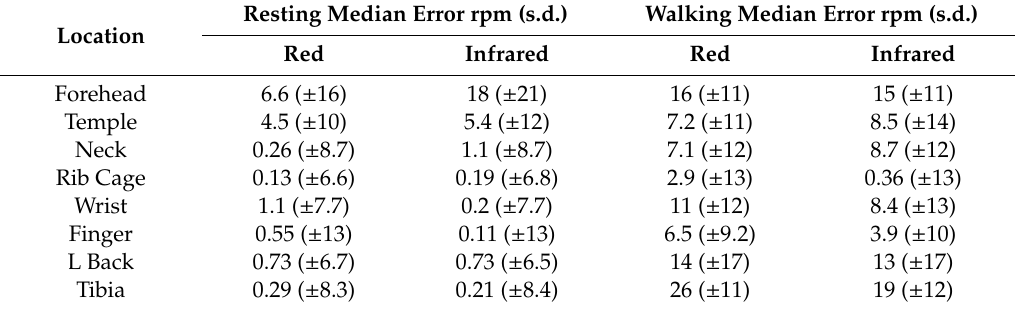
Table 5. Median error for respiration calculation at eight anatomical location using the red Rib Cage and infrared channels at rest and walking. Median error is presented as the respirations per minute (rpm) deviation from the respiration shirt baseline data. Wrist refers to the posterior distal forearm. Neck refers to the back of the neck. L Back refers to lower back. Respirations per minute is denoted as rpm.